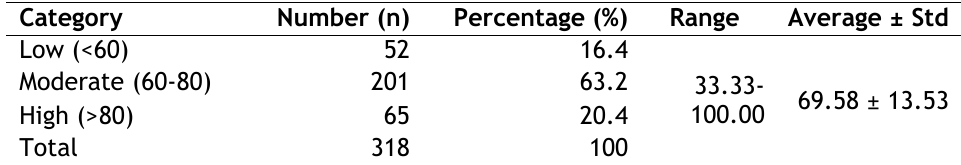
Table 3. Category and descriptive analysis of consumer